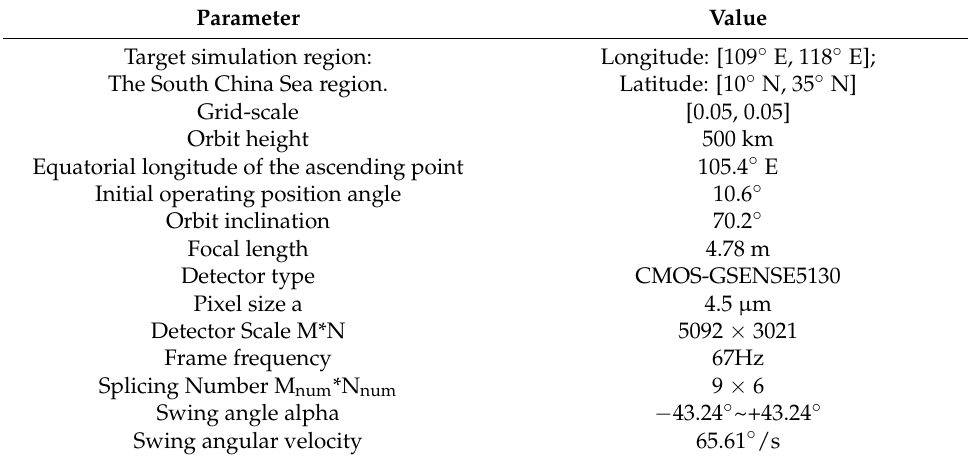
Table 2. Design results of the system parameters at a typical low orbital altitude.